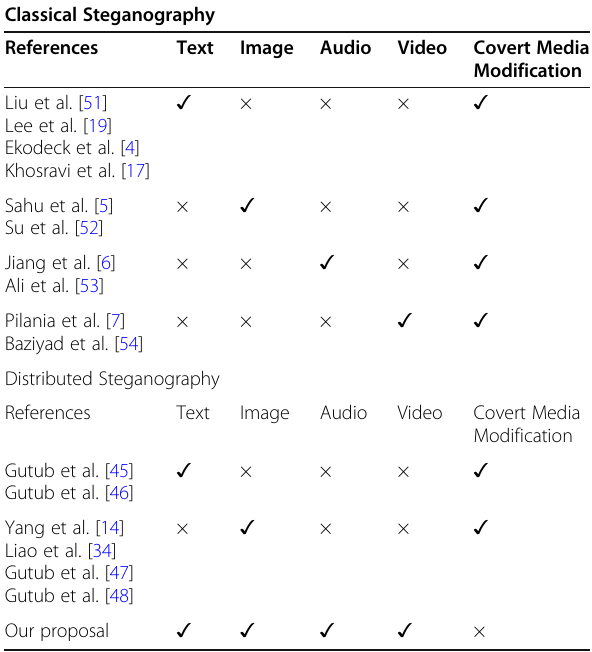
Table 1 Steganographic techniques comparaison based on the covert media type and covert media